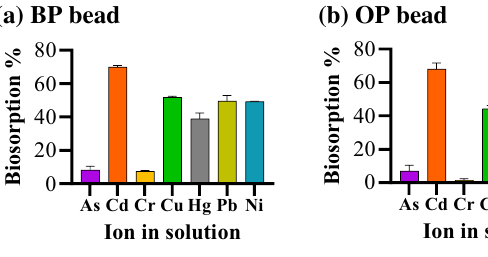
Fig. 2 Biosorption of ions. One bead was incubated in a cocktail solution containing all seven ions each at 0.1 mgL-1, pH 7.0, 25 °C with continuous shaking at 250 rpm for 10 h. a BP bead, b OP bead and c PP